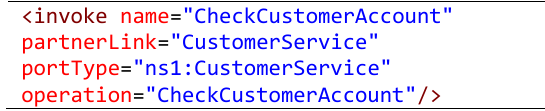
Fig. 8. Constructor of an Invoke Activity